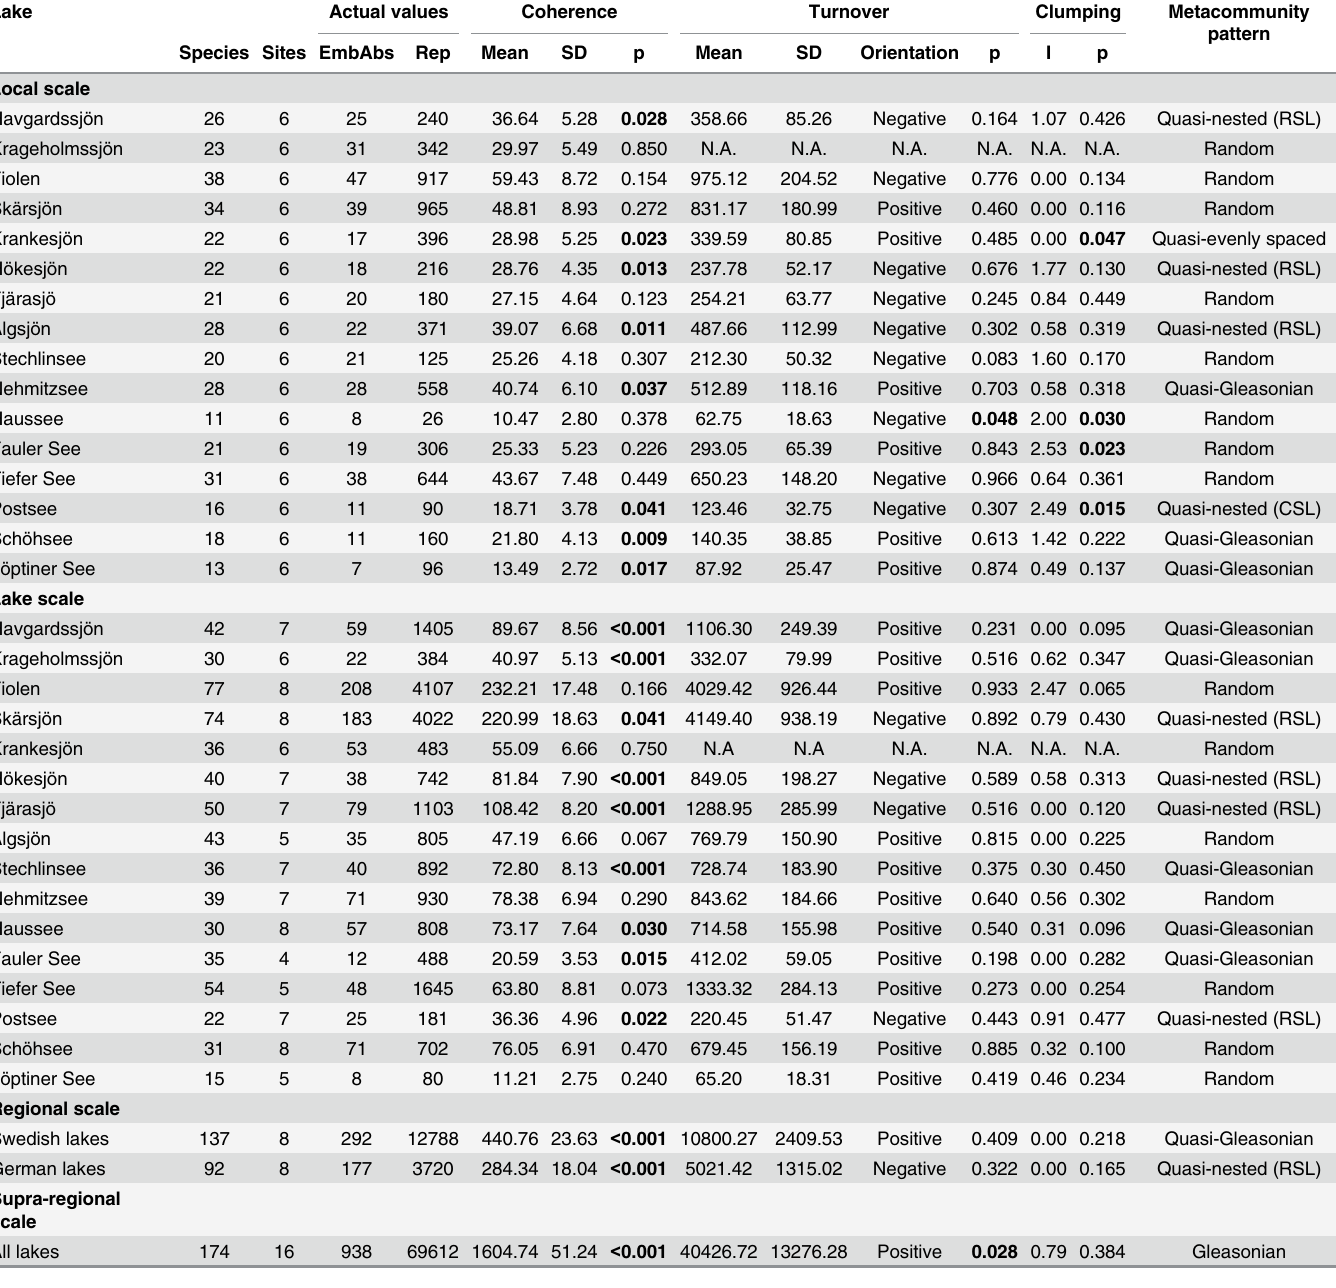
Table 2. Results of the EMS analysis of nematodes in 16 European lakes at four different geographical scales. Metacommunity patterns were identi- fied according to the method of Presley et al. [17]. Coherence and turnover were calculated by determining the number of embedded absences and replace- ments in the interaction matrix vs. the null distribution. Significant values are shown in bold face. N.A., not